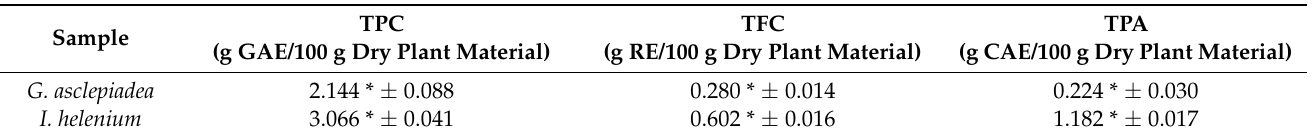
Table 1. Total polyphenolic (TPC), flavonoid (TFC), and phenolic acids (TPA) content of Gentiana asclepiadea and Inula helenium